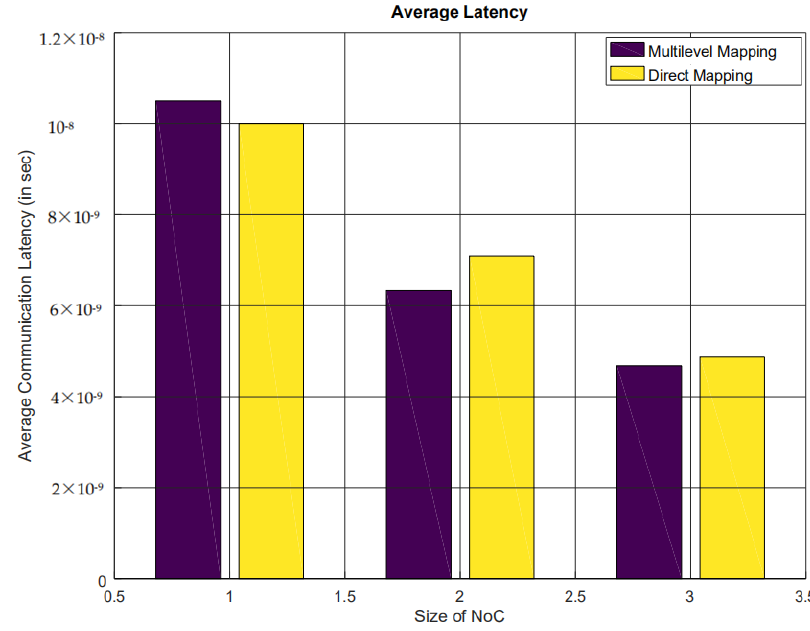
Figure 16. Average